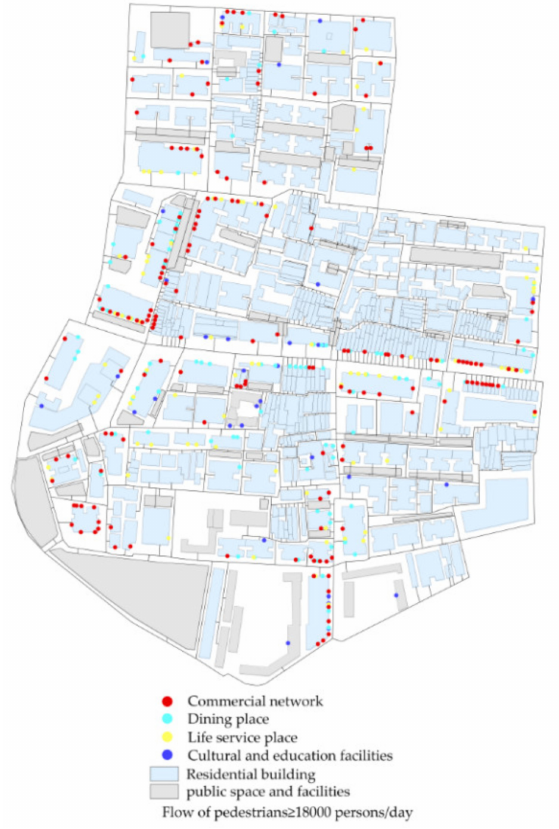
Figure 5. The distribution of POI within the